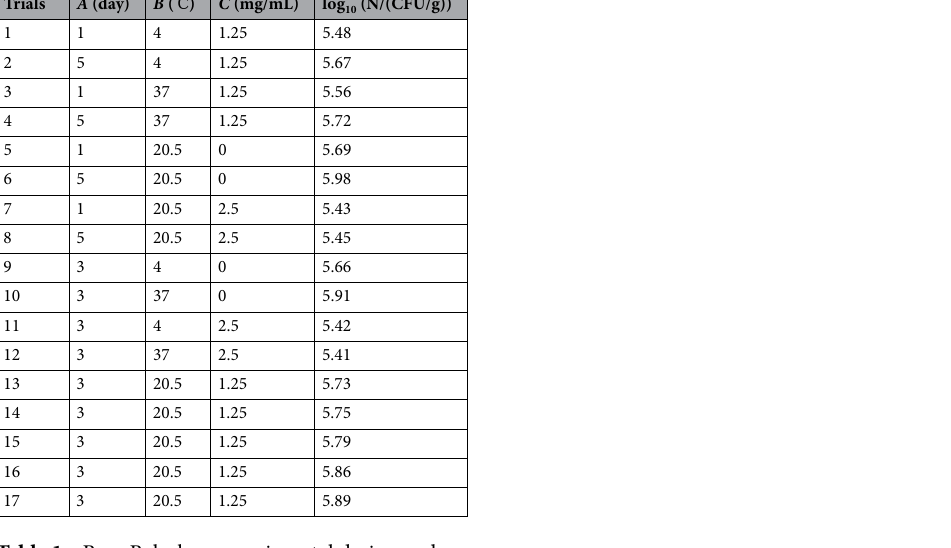
Determination of intracellular ATP.